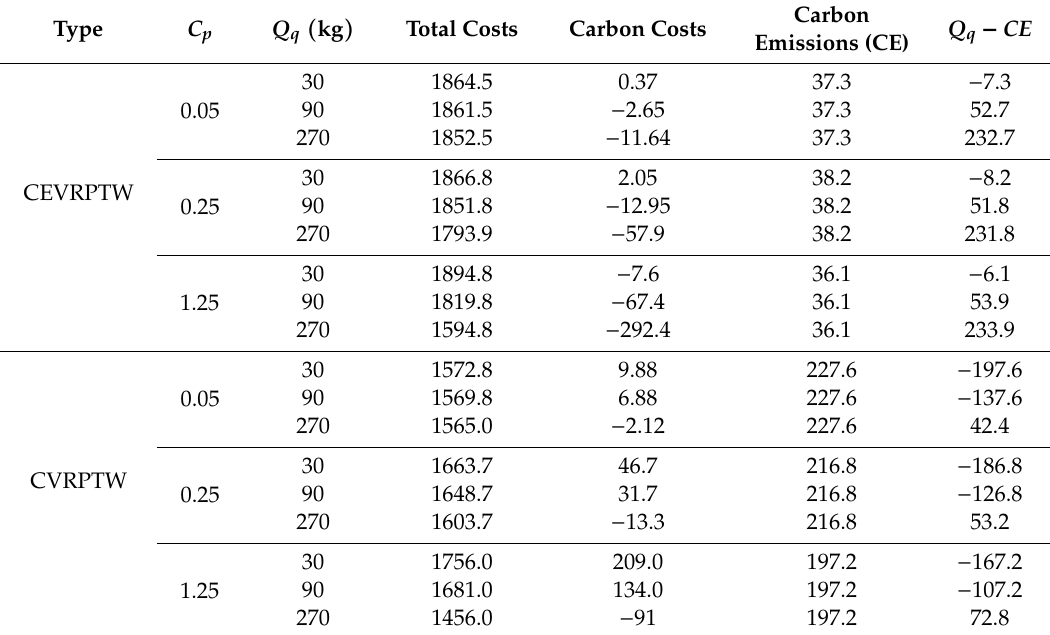
Table 8. The results of CEVRPTW and CVRPTW with di ff erent carbon price and